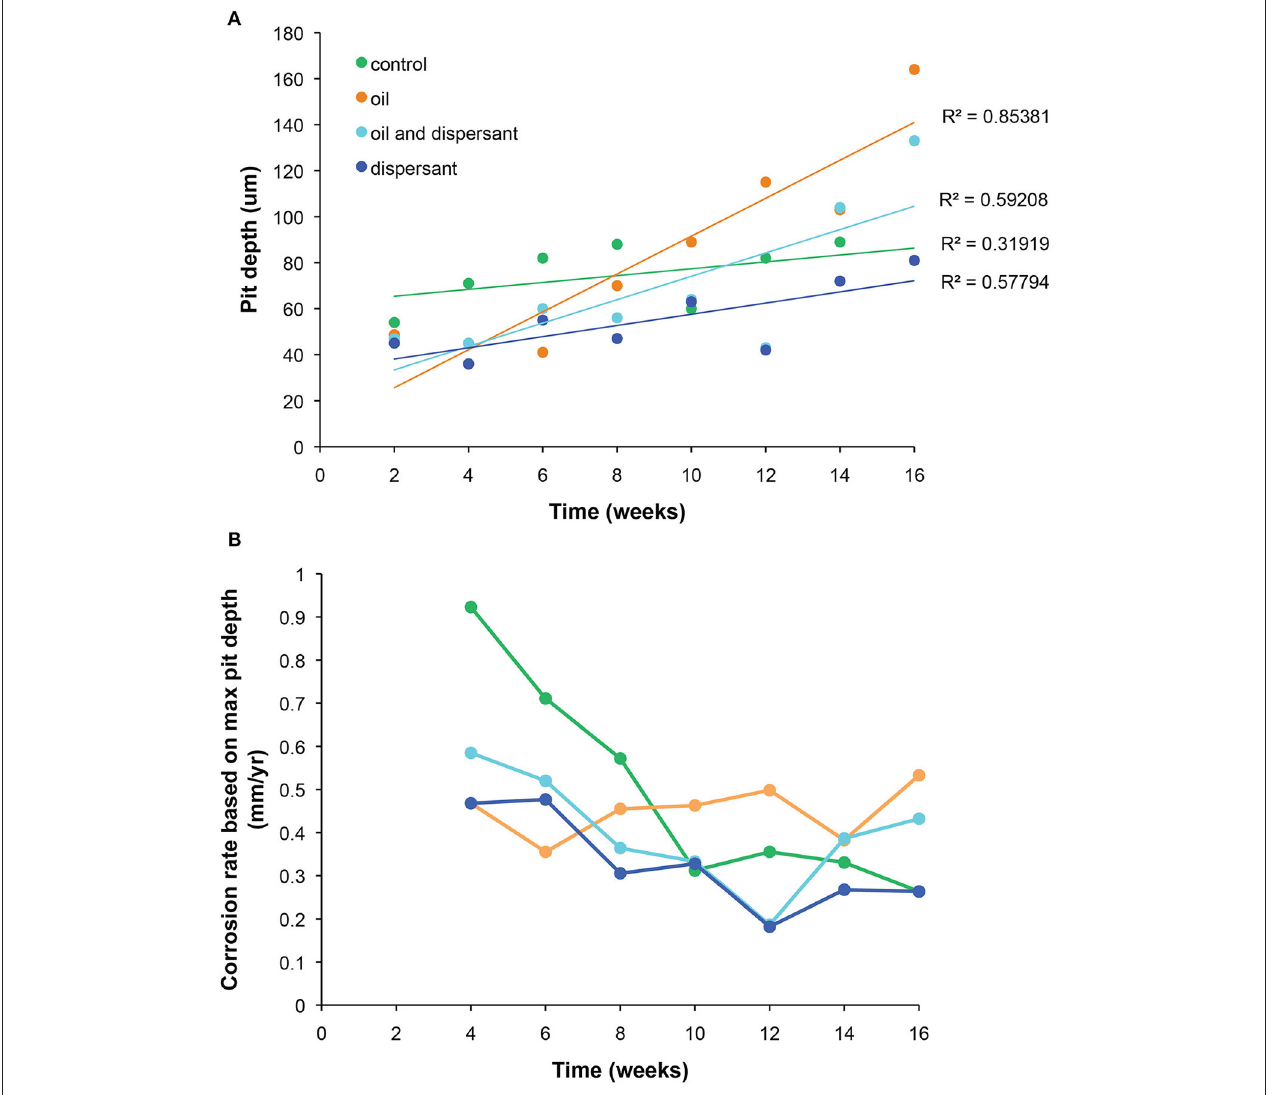
FIGURE 5 | Surface profilometry analysis of carbon steel disks (CSDs). (A) Maximum pitting depth ( µ m) resulting from abiotic and biotic processes is plotted against time (16 weeks) for all treatments. (B) Carbon steel disk (CSD) corrosion rates based on maximum pitting depth, resulting from abiotic and biotic processes, plotted against time for all